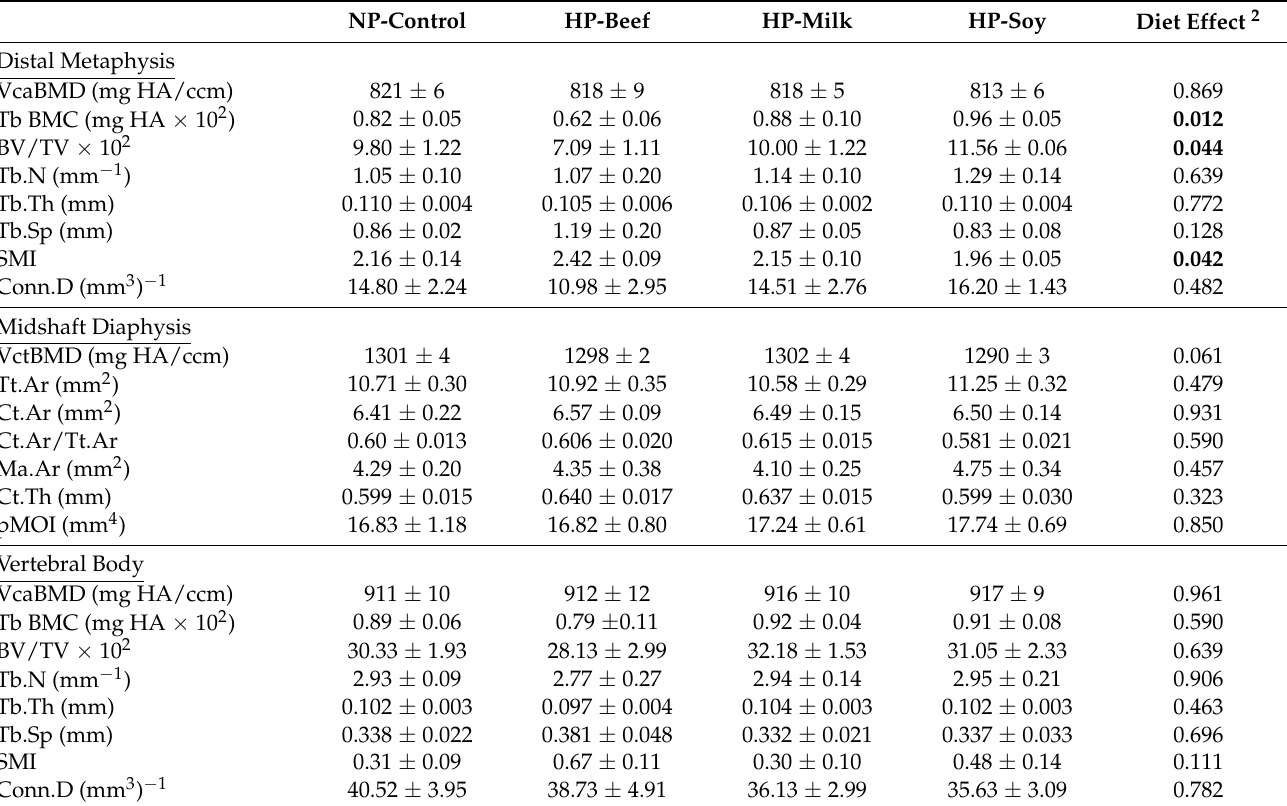
Table 5. Main effect of diet on bone microarchitecture following 12 weeks of energy restriction 1 .